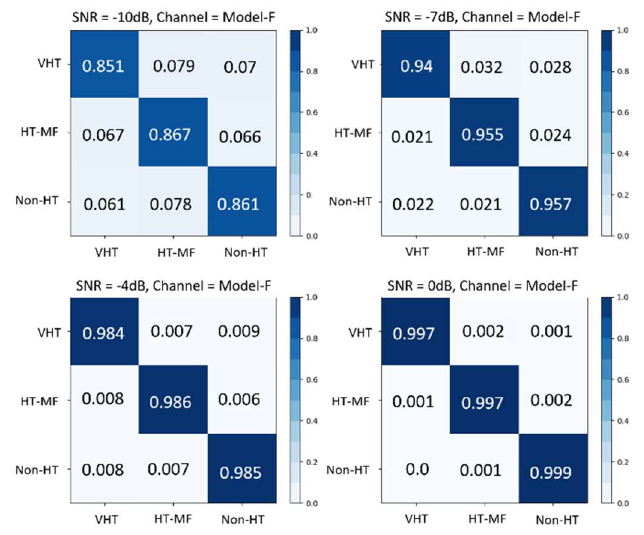
Figure 7. Confusion matrix for different signal-to-noise ratios (SNRs) in Model-F.